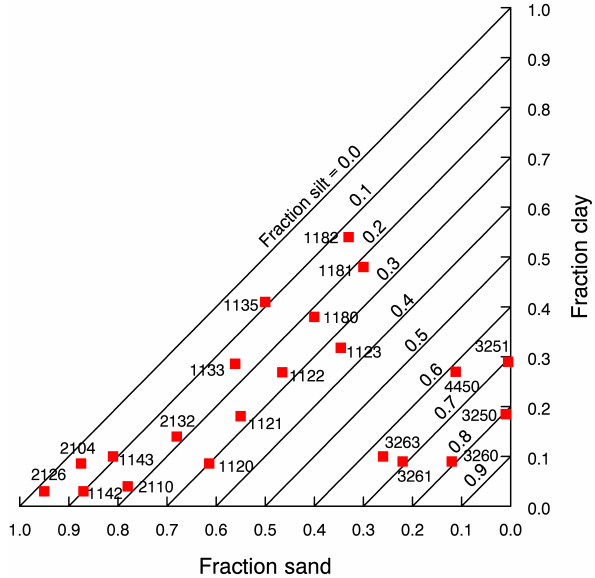
Figure 1. The textures of the soils used to test the fitting capability of selected soil water retention curve parameterizations. The num- bers next to the data points are the identifiers used in the UNSODA database to distinguish individual